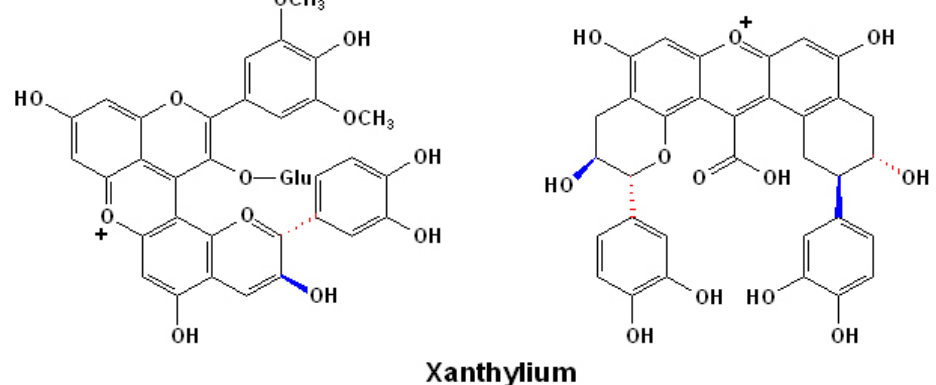
Figure 7. Structures of some xanthylium pigments